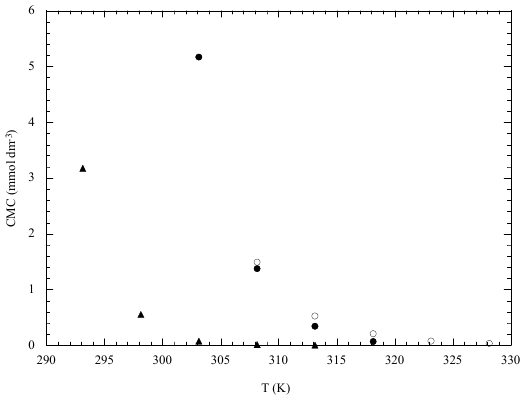
PO EO ( ▲ ) in water. Data are from Ref. 97 69 97